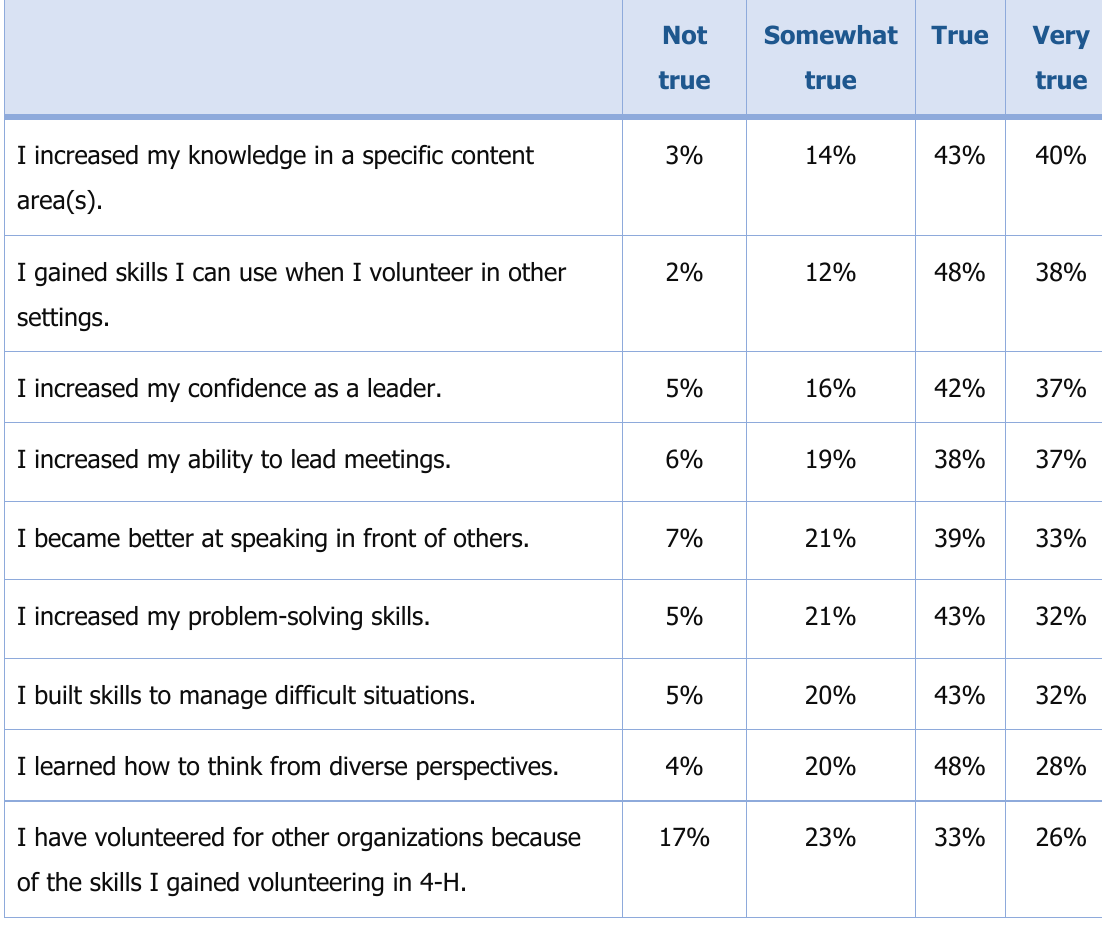
Not Somewhat True Very true true